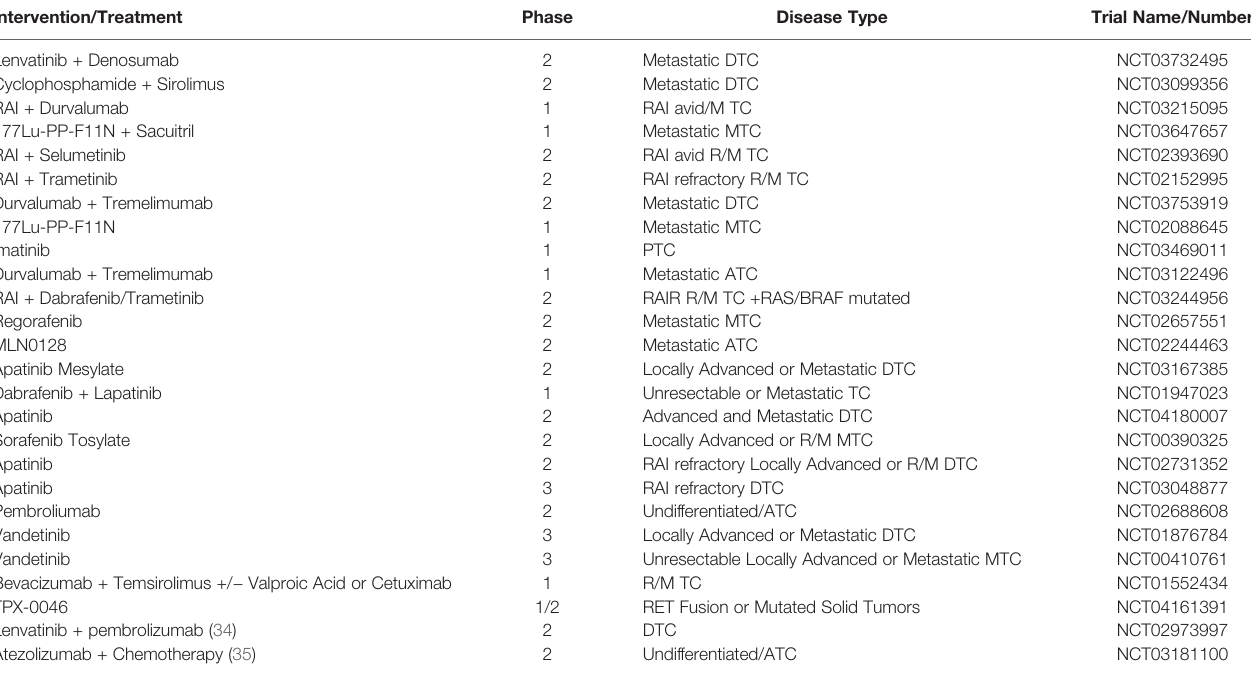
TABLE 2 | Ongoing Clinical trials for Radioactive Iodine Refractory Thyroid Cancer. Intervention/Treatment Phase Disease